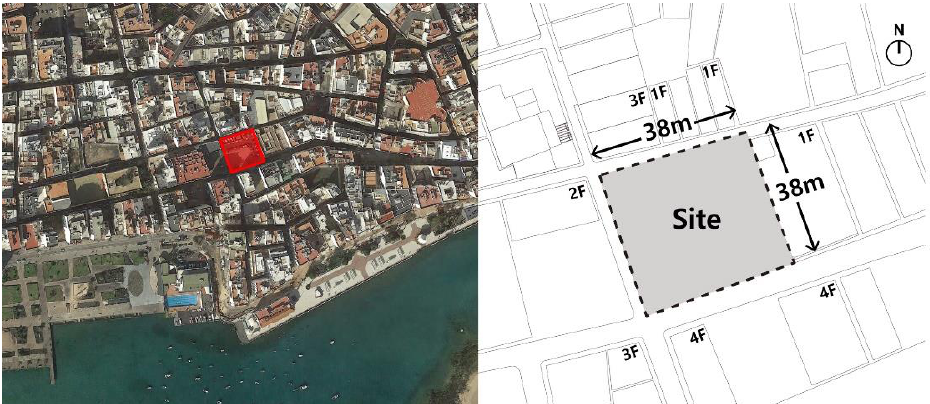
Figure 1. Surroundings of the research subject and its physical size.